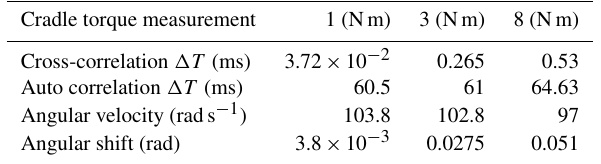
Table 1. Experimental results.